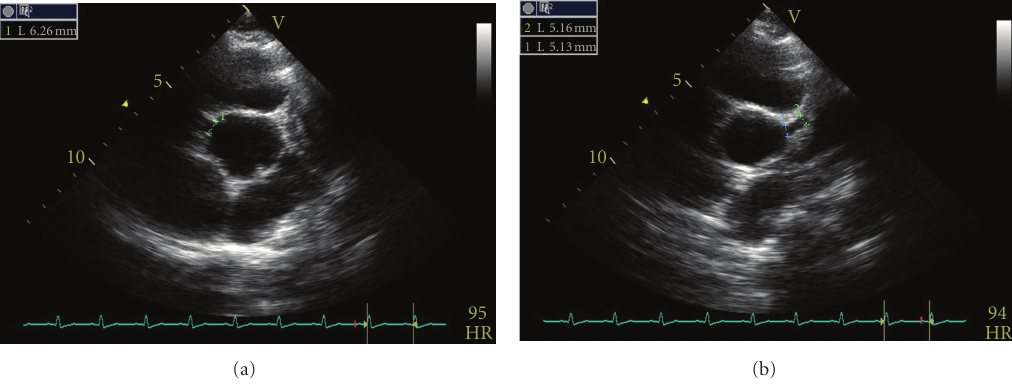
Figure 2: Coronary artery ectasia. Right coronary artery diameter measuring 6mm (a) and left coronary artery diameter measuring 5mm